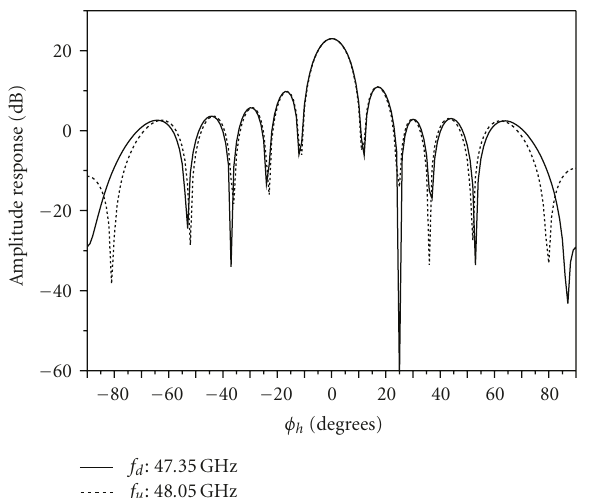
Figure 12: Comparison of the beam pattern of the receiver and the transmitter of the HUT using MVB.